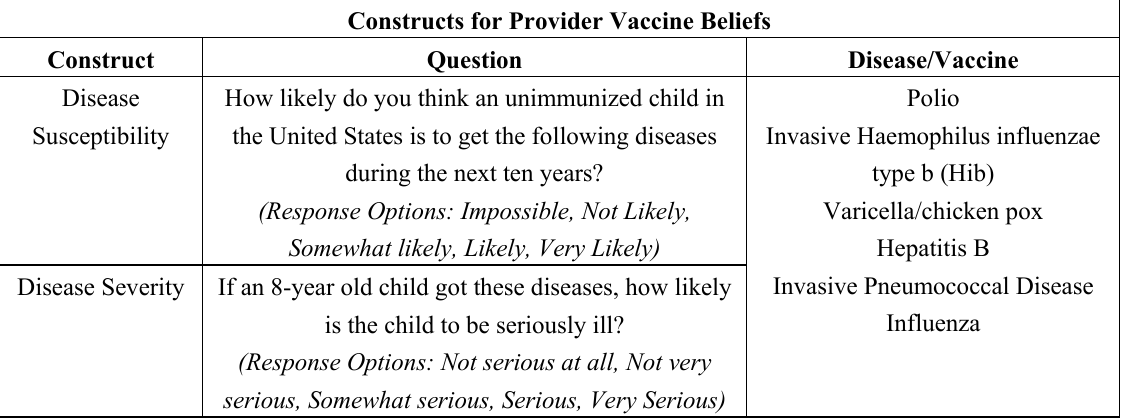
Table 1. Questions asked of providers for each of the diseases and vaccines